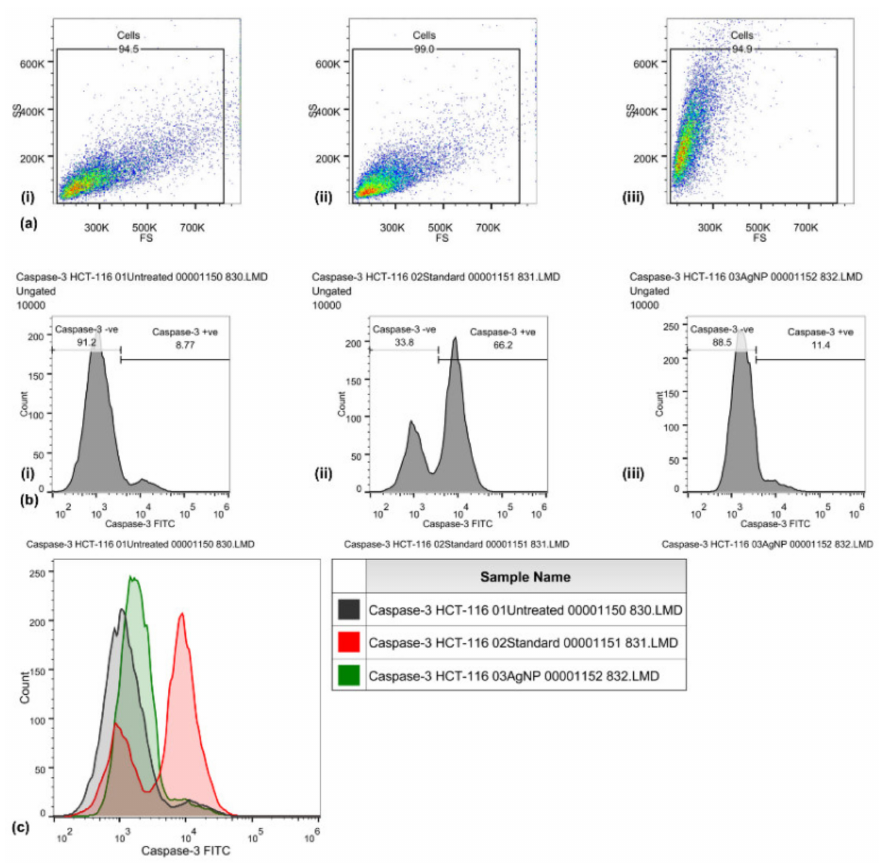
Figure 3. Caspase-3 activities induced by biosynthesized silver nanoparticles in HCT-116 cells, quantified through FITC rabbit anti-active caspase-3 IgG antibody (BD Biosciences). Representative FS/SS dot plots ( a ) of uniform population, percentage of cells with high caspase-3 activity assessed by dUTP-FITC ( b ) for control (i), standard EGF (ii), and biosynthesized silver nanoparticles (AgNPs) (iii). Flow cytometry histogram overlays ( c ) show the intensity of dUTP-FITC in the HCT-116 cells that are untreated (control), those treated with cisplatin (standard), and those treated with biosynthesized silver nanoparticles